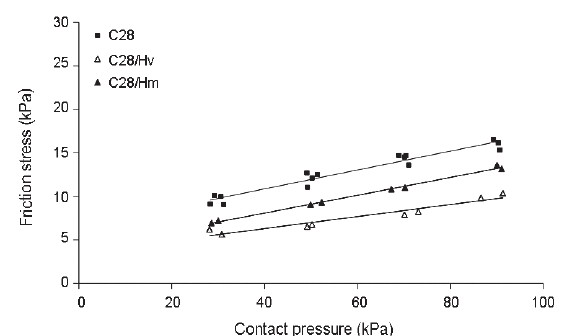
Fig. 12. Evolution of friction stress as a function of contact pressure for C36 with release